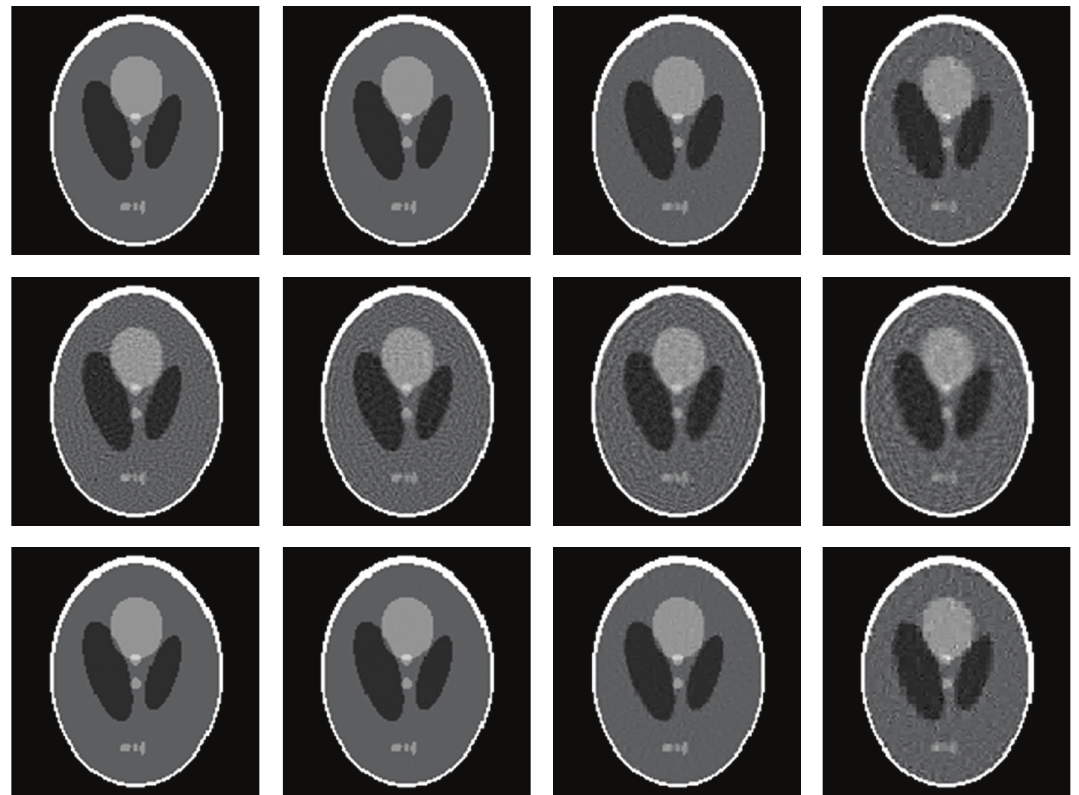
Figure 3: Reconstructed 128 × 128 images from noise-free projection datasets. The 1st, 2nd, and 3rd rows are reconstructed using Scheme- A, Scheme-B, and Scheme-C, respectively, and the 1st, 2nd, 3rd, and 4th columns are from 55, 45, 35, and 25 views respectively (the display window: [0 0 .